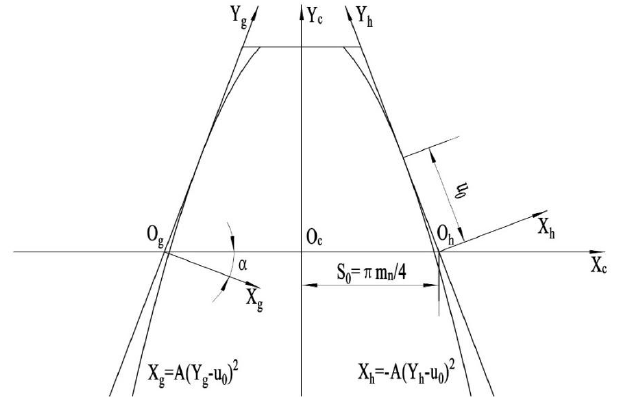
Figure 1. The two tooth surfaces, g and h , of a gear.